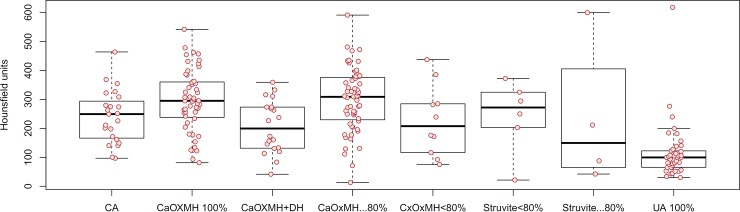
Stone heterogeneity index in noncontrast computed tomography values according to stone composition.CA: carbonate apatite; CaOx: calcium oxalate; MH: monohydrate; DH: dehydrate; UA: uric acid.